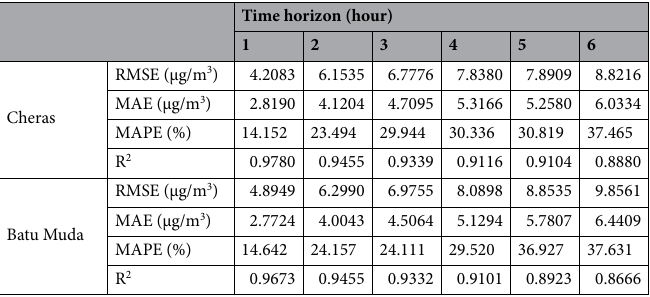
Table 6. Multistep ahead forecasting of